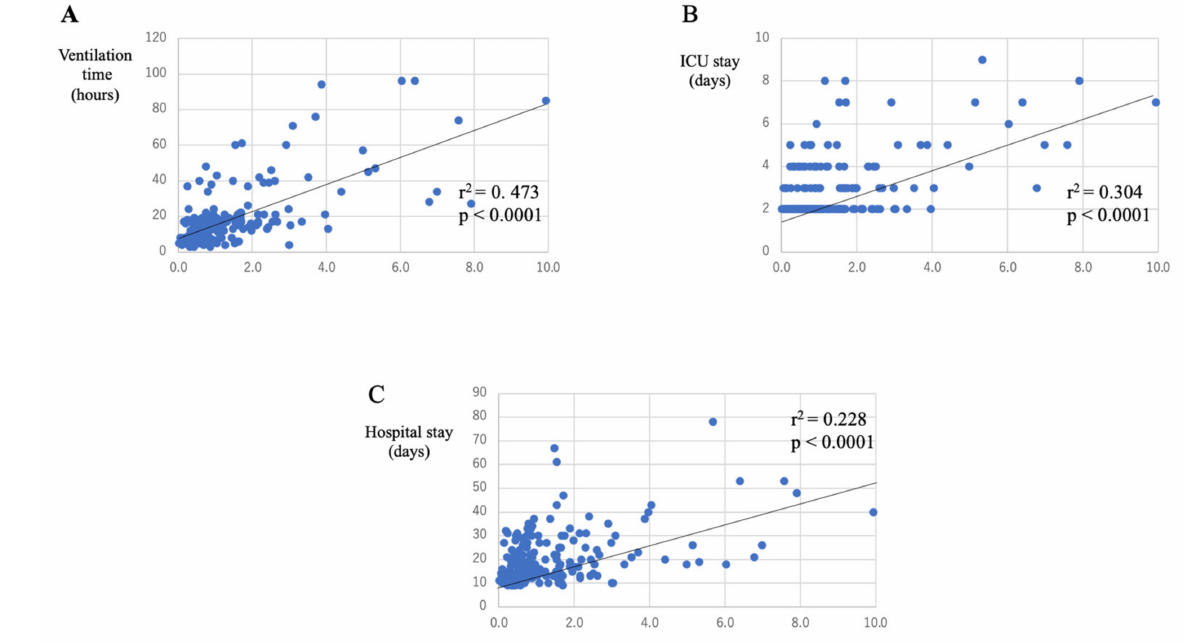
Figure 3. Correlations between respiratory index (RI) and postoperative course. RI is positively correlated with DMV ( A ), ICU stays ( B ), and hospital stays ( C ). DMV, duration of mechanical ventilation; ICU, intensive care